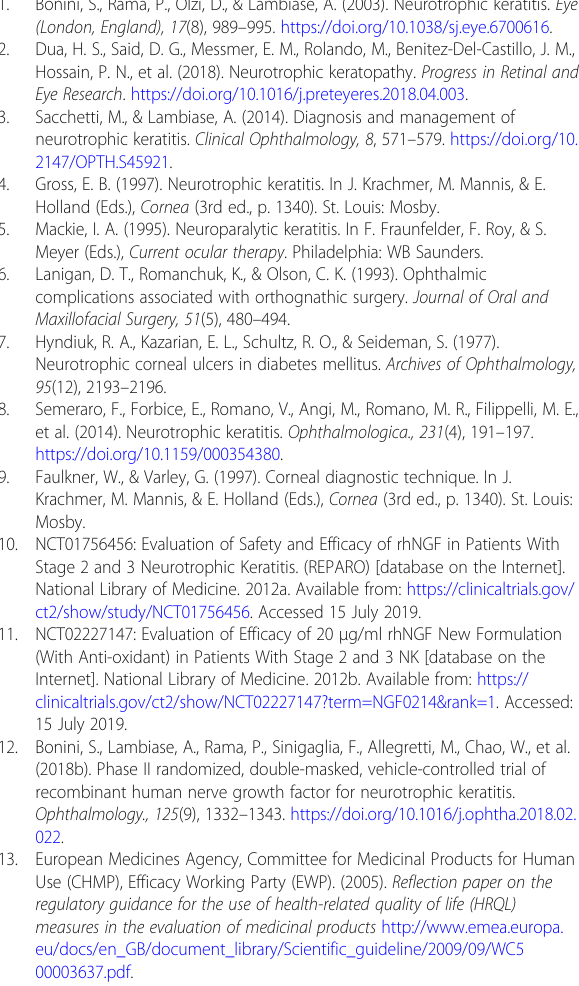
Additional file 1: Figure S1. Conceptual Framework of the Draft